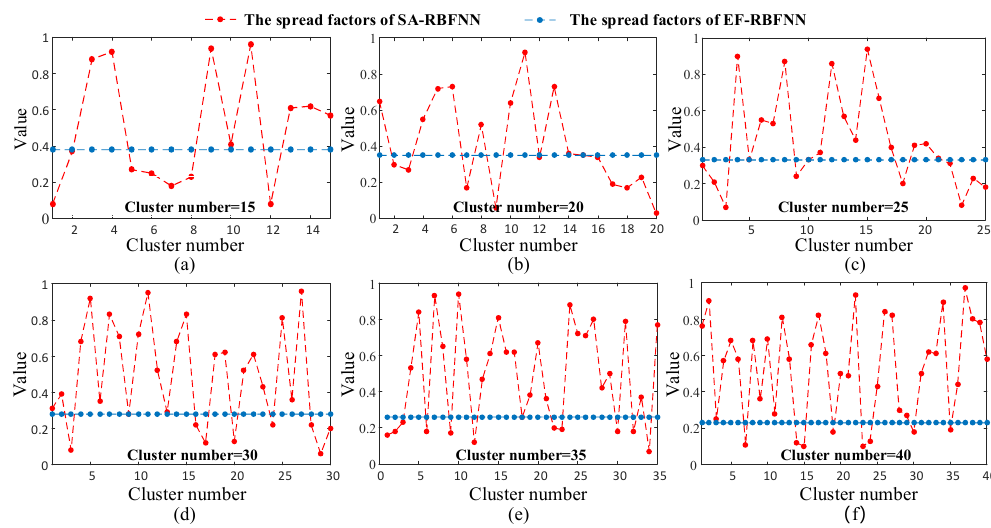
Figure 4. Spread factors of SA-RBFNN and EF-RBFNN under different cluster number setting.